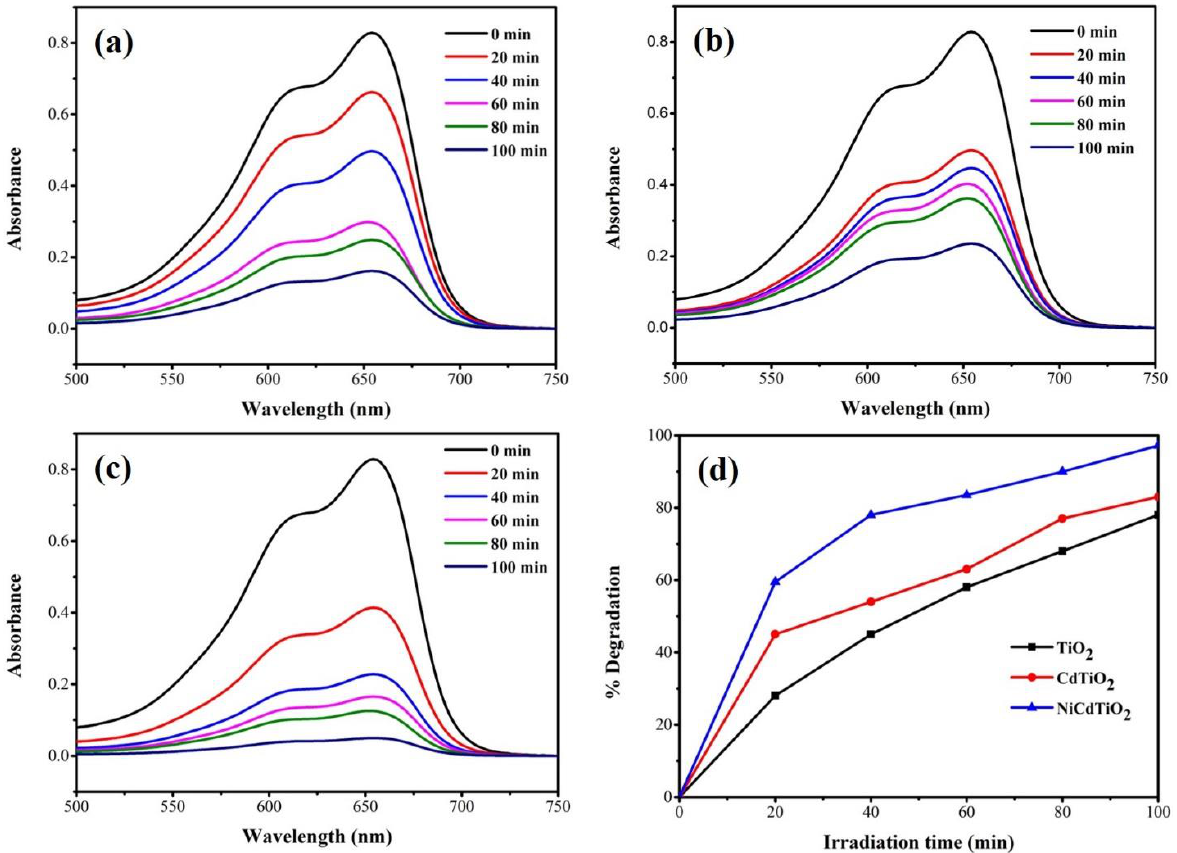
Figure 14. UV – VIS absorption spectra of MG degraded in the presence of ( a ) TiO 2 ( b ) CdTiO 2 ( c ) NiCdTiO 2 ( d ) Comparison of %degradation of MG dye.